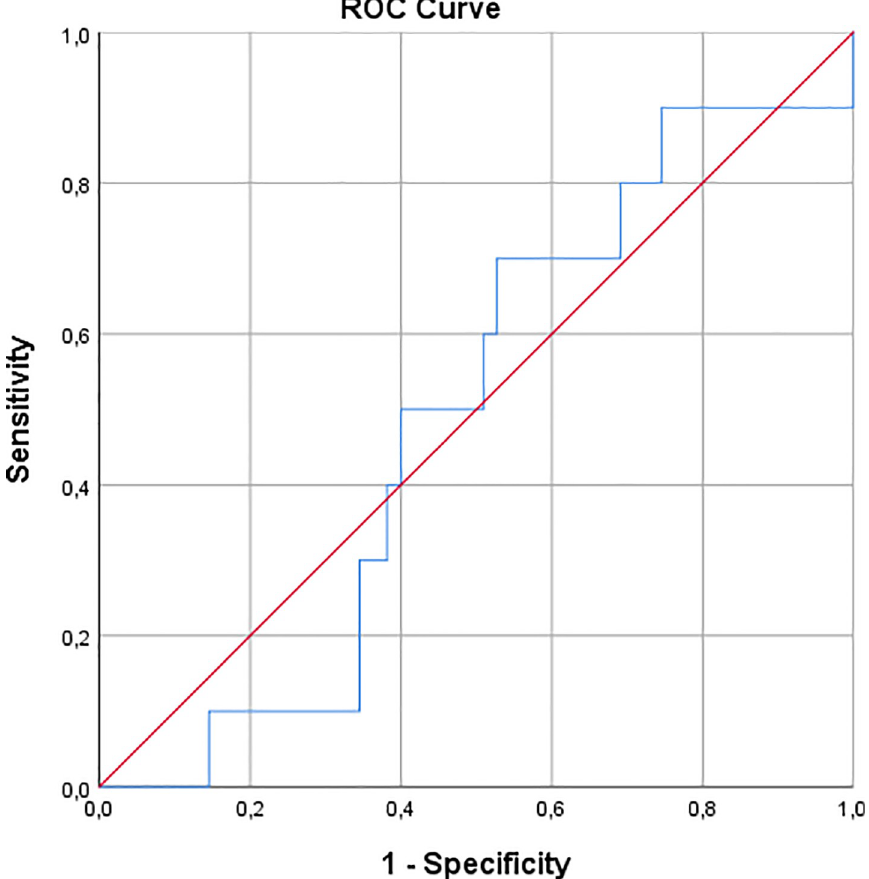
Fig 1. Receiver operating characteristic curve of DO 2 and Δ eGFR > 10%. DO 2 –oxygen delivery; Δ eGFR > 10%— more than 10% decrease in estimated glomerular filtration rate.